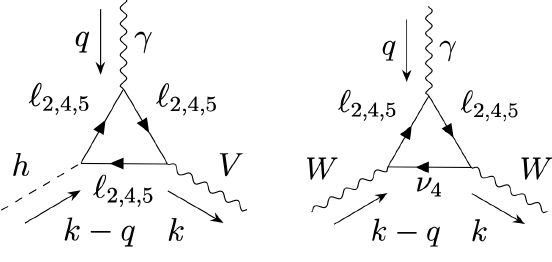
Figure 3 . The inner loop inside the blob of figure